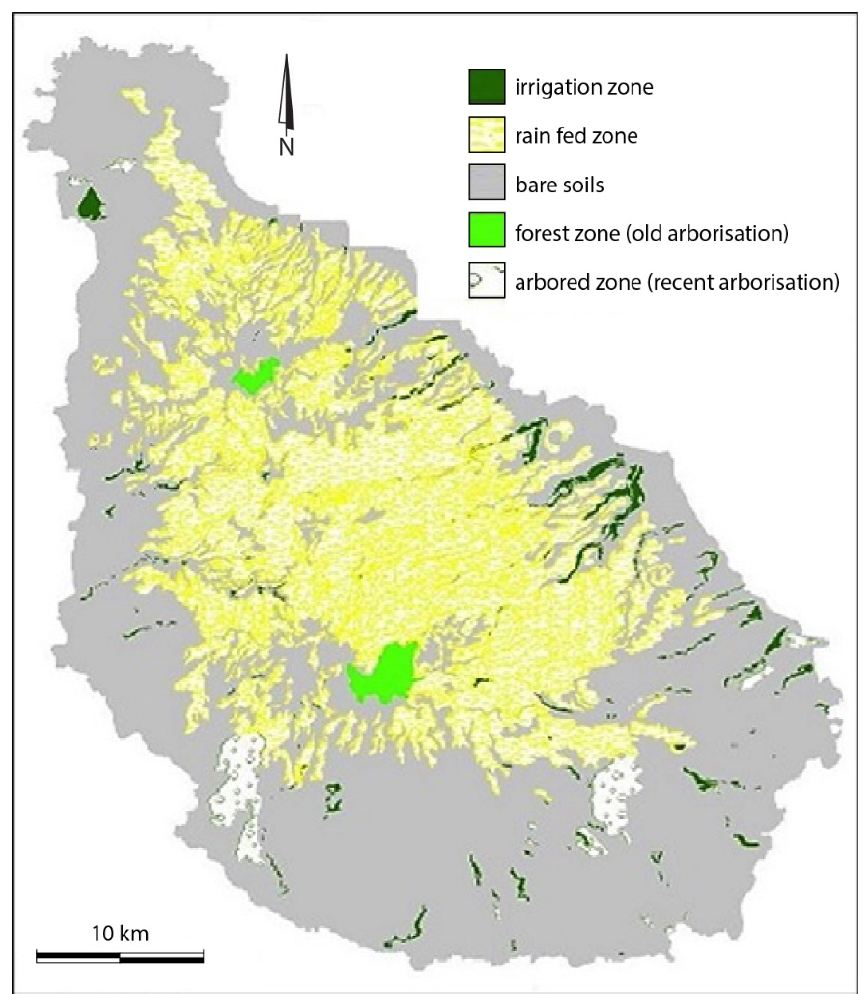
Figure 6. Land use of Santiago Island (adapted [47,48]).